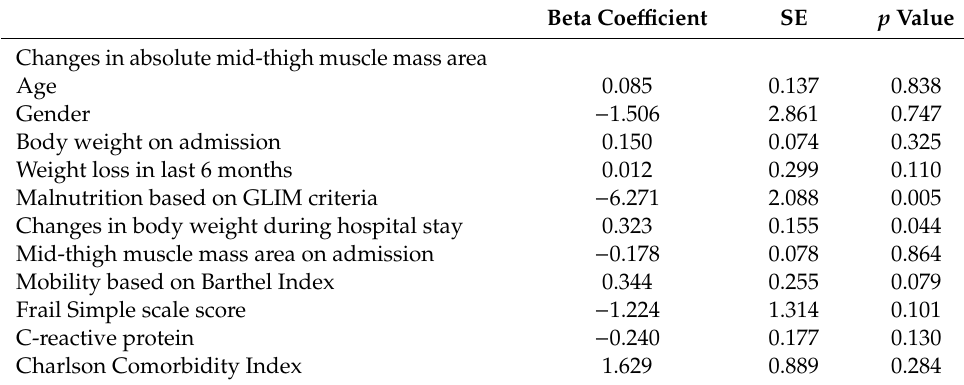
Table 4. Stepwise multiple regression analysis of risk factors associated with changes in mid-thigh muscle mass area in total population ( n =